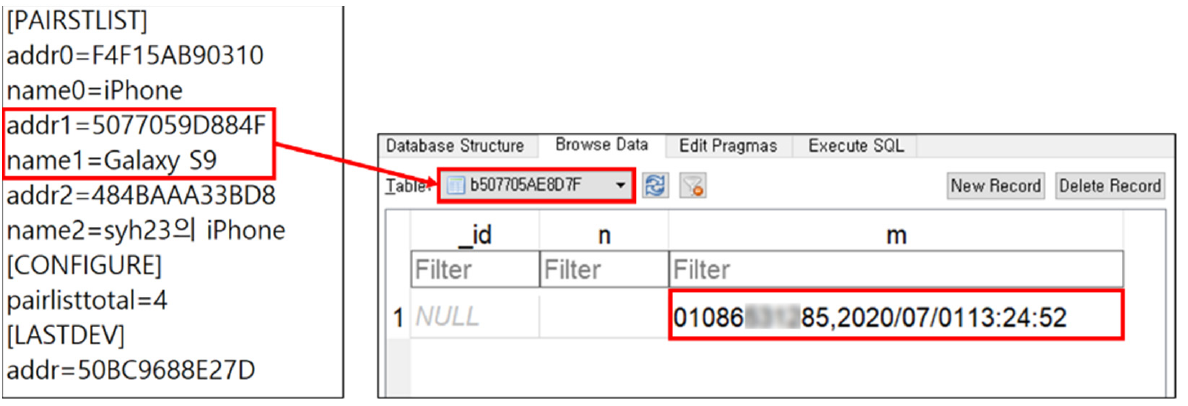
Figure 7. The red frames indicate the storage of the IVI system: ( a ) HDD acquired from BMW NBT HU EVO, ( b ) NAND flash acquired from Belsee Best Aftermarket Auto.